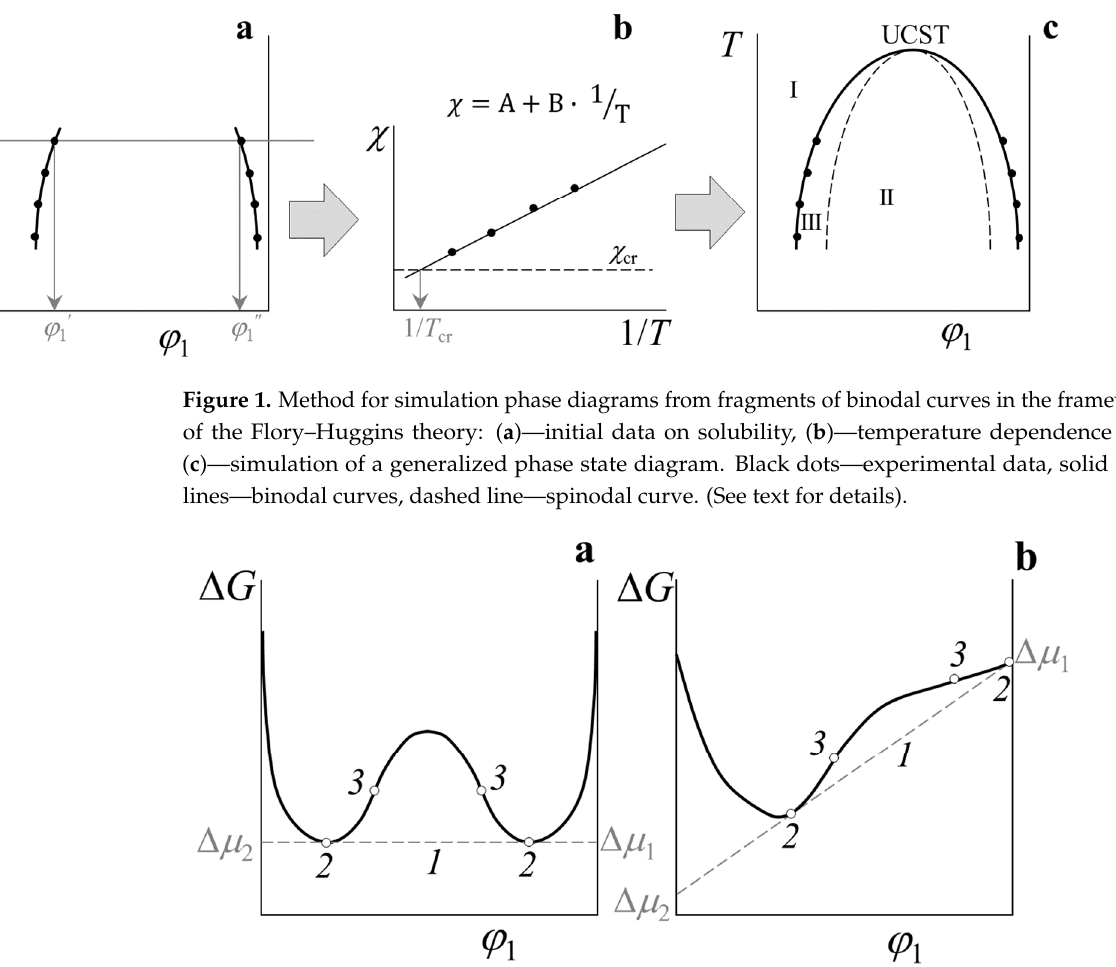
Figure 2. Concentration dependence of the free energy of mixing for symmetric ( a ) and asymmetric ( b ) cases. Common tangent (1), binodal (2), and spinodal (3)